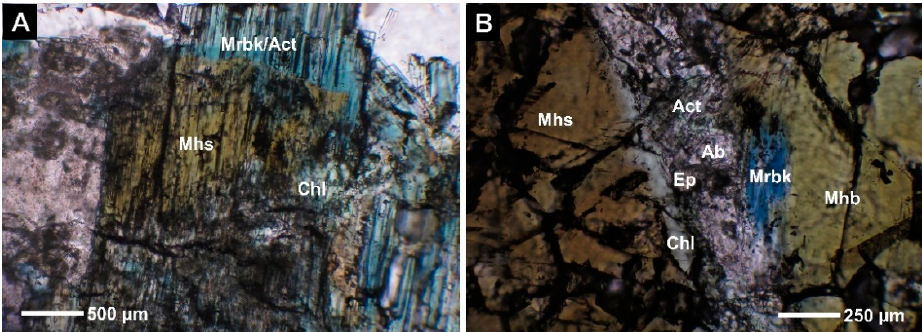
Figure 11. Metagabbro block in Permian evaporitic sediments of the Silica Nappe at Gemerská Hôrka (s. SA-6): ( A ) magmatic brown amphibole (Mhs) overgrown by metamorphic bluish Amp (Mrbk/Act); ( B ) brown amphibole (Mhs, Mhb) crosscut by the metamorphic veinlet of bluish Amp (Mrbk), colour-less Act, Ep, Ab and pale-green Chl. Pictures A and B at II N.